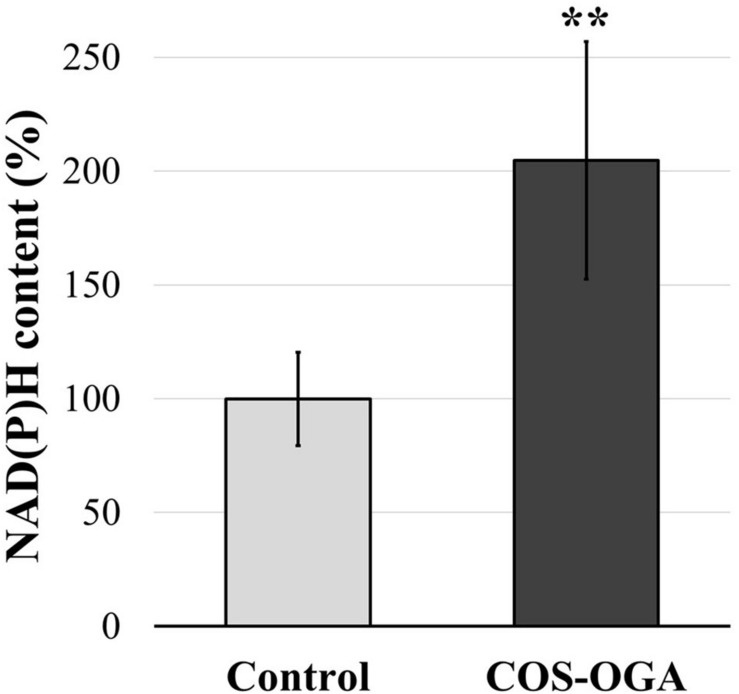
Reduced nicotinamide adenine dinucleotide phosphate [NAD(P)H] content of tomato leaves after three sprayings with chitooligosaccharides–oligogalacturonides (COS-OGA; 62.5 mg/l). Tomato leaves were harvested 24 h after the third treatment. The average NAD(P)H content is expressed as the average percentage of the control ± standard deviation (n = 6). **indicates a statistically significant difference to control according to Student’s t test (p < 0.01, R).